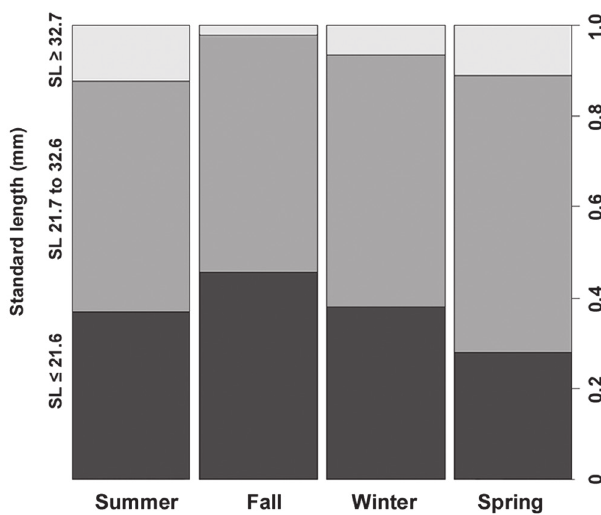
Fig. 5. Seasonal distribution of Atlantirivulus riograndensis by frequency of standard length (SL). Individuals collected at the Banhado dos Pachecos wildlife refuge, Viamão, Rio Grande do Sul, Brazil, in